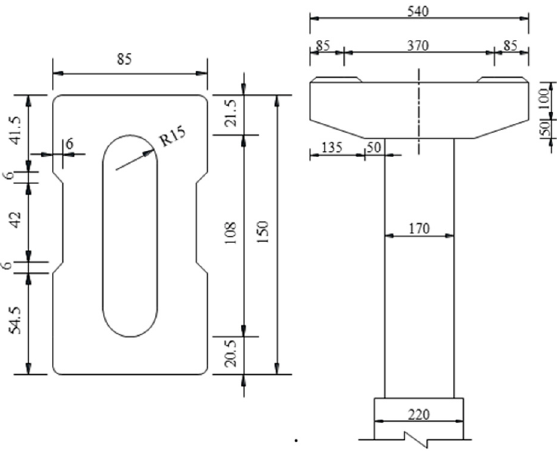
Figure 3. Bridge structure in this paper (mm).